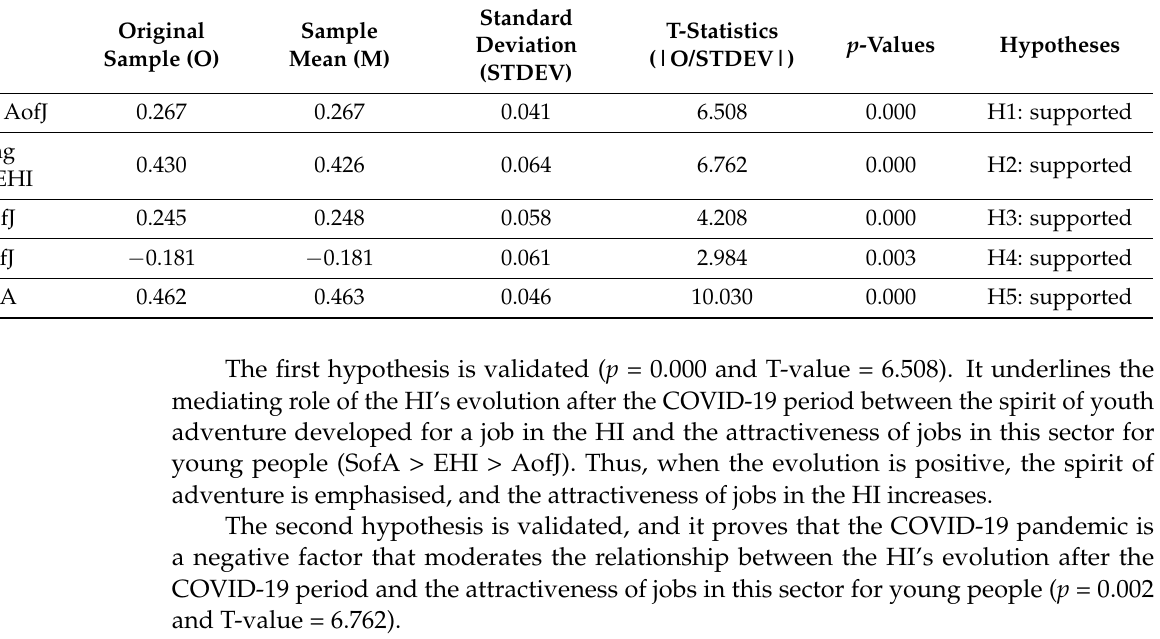
Table 2. The breakdown of the hypotheses